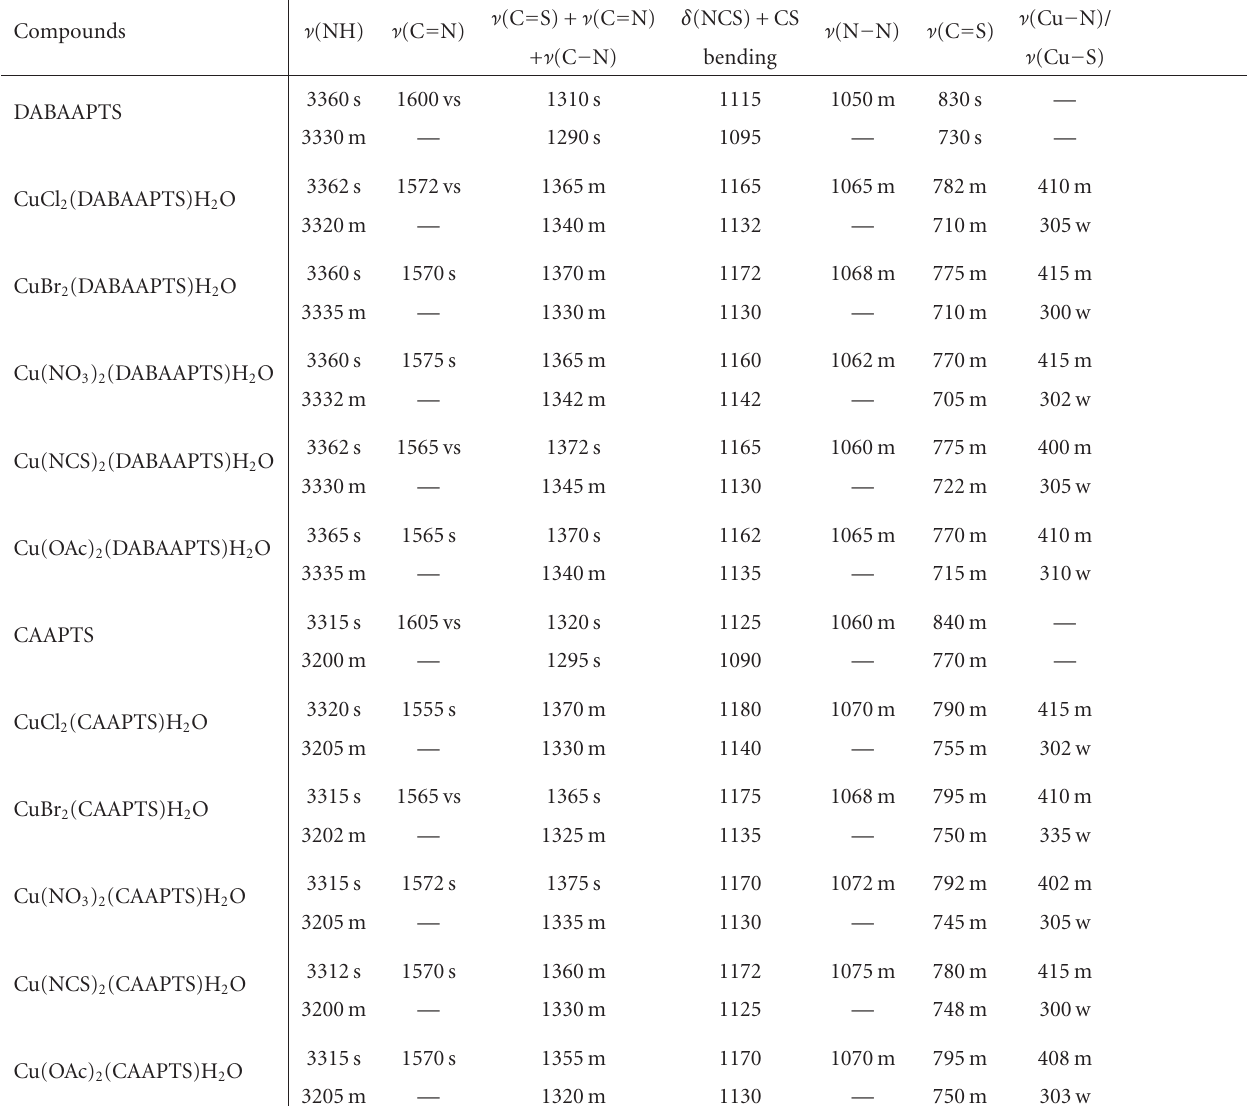
Table 4: Key IR bands (cm − 1 ) of DABAAPTS and CAAPTS and their Cu 2+ complexes.